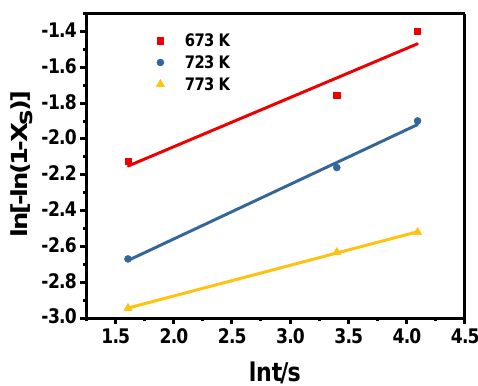
Figure 8. The relationship between ln[ − ln(1 − X S )] and lnt.